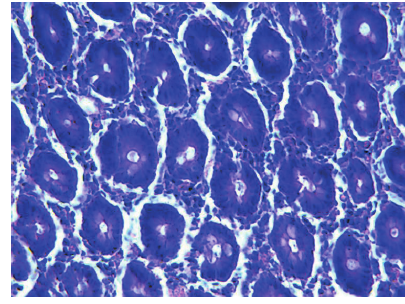
Figure 6b: Model group.